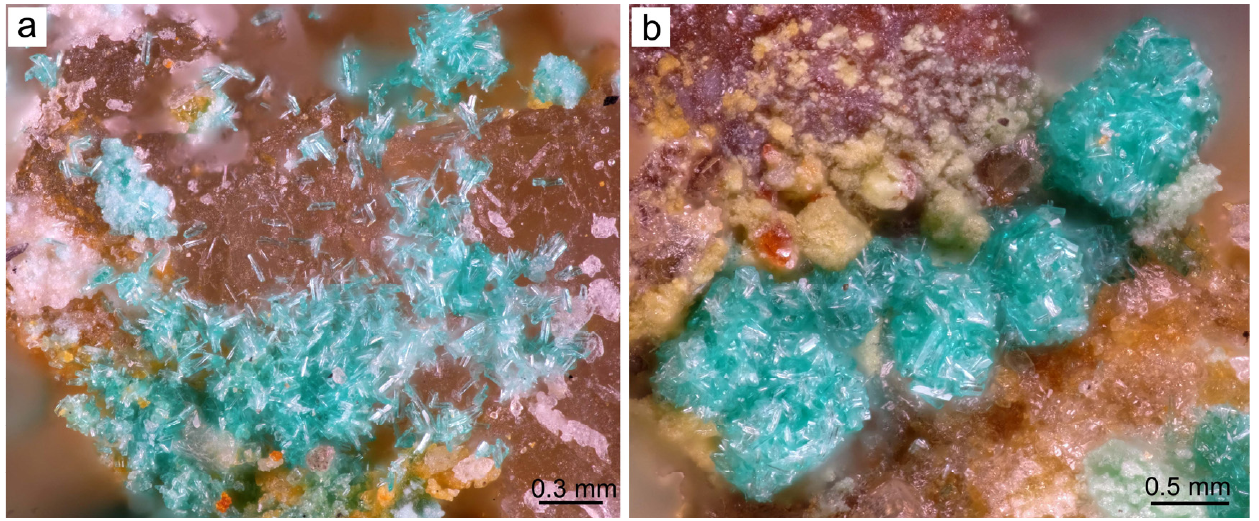
Figure 17. Optical images showing posnjakite crystals from the Mastricarro Barite Mine (Catanzaro, southern Italy): ( a ) hundreds of tiny pale-green elongated prismatic crystals forming sprays of posnjakite; ( b ) spherical aggregates of elongated tabular posnjakite crystals.